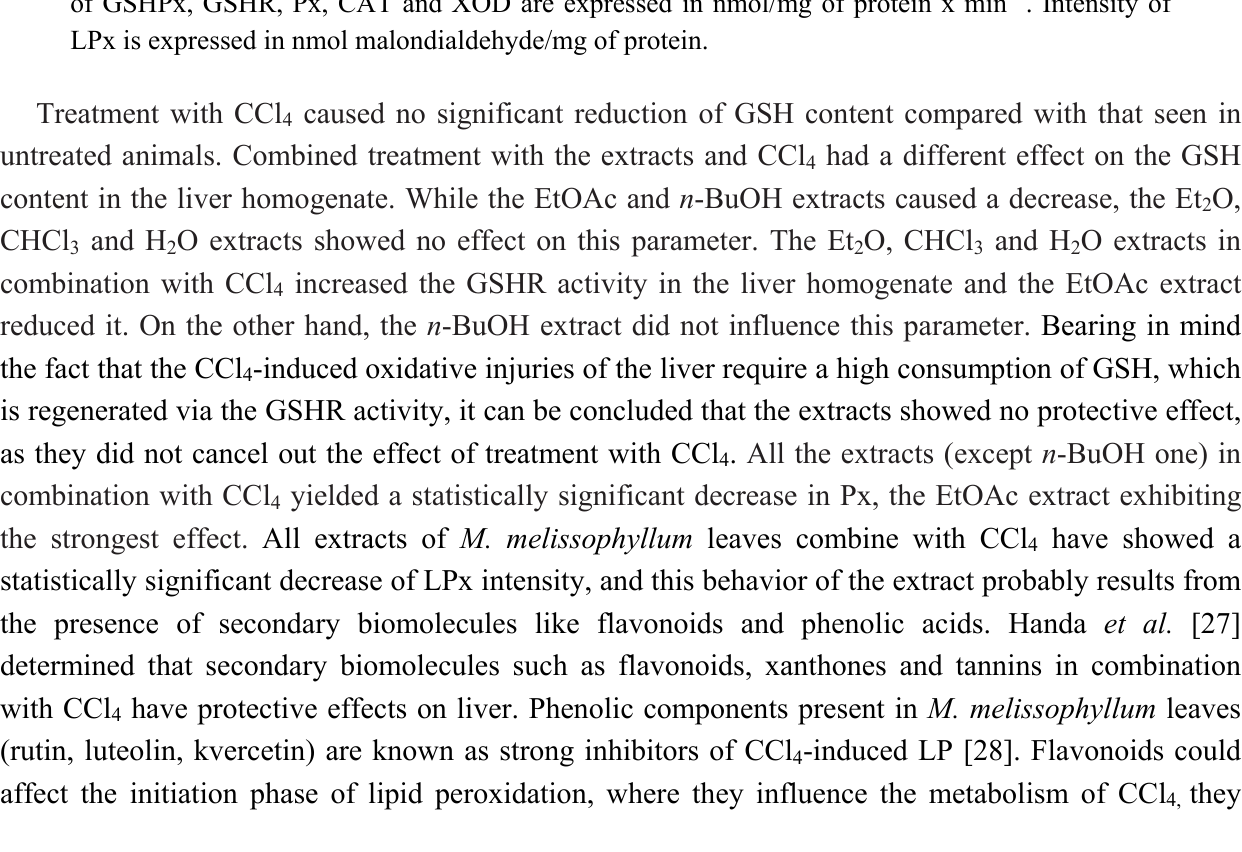
on the liver homogenate 4